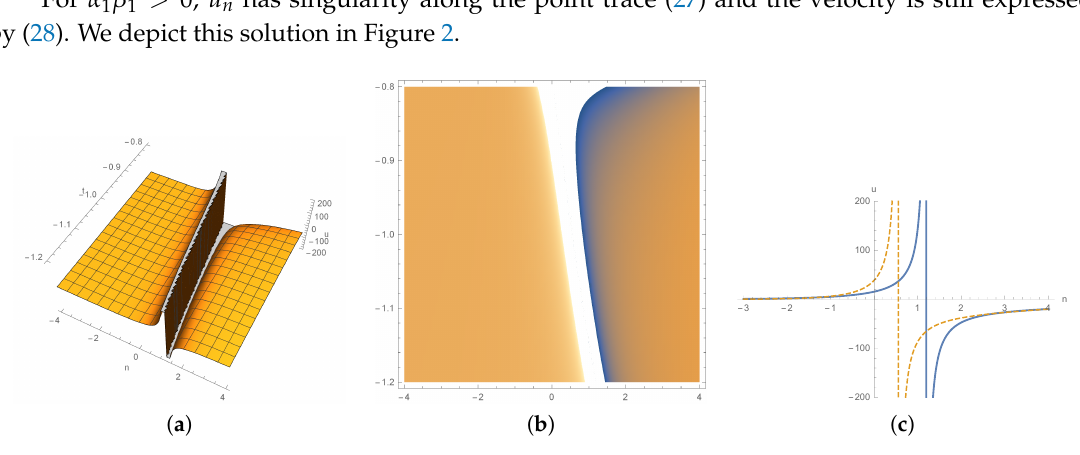
Figure 2. u n given by (26) for c 1 = 1.5, d 1 = 0.01, α 1 = 1 and β 1 = 1. ( a ) shape and motion; ( b ) a contour plot of ( a ) with range n ∈ [ 4,4 ] and t ∈ [ − 1.2, − 0.8 ] ; ( c ) waves in blue (solid line) and yellow (dotted line) stand for plot ( a ) at t = − 1.2 and t = − 1, respectively.